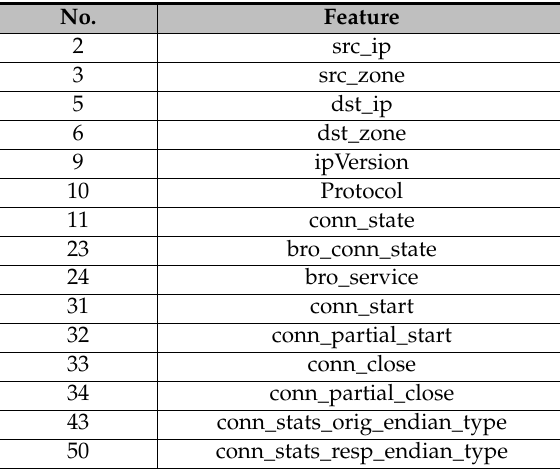
Table 7. Categorical (factor) features eliminated from the feature importance evaluation phase.